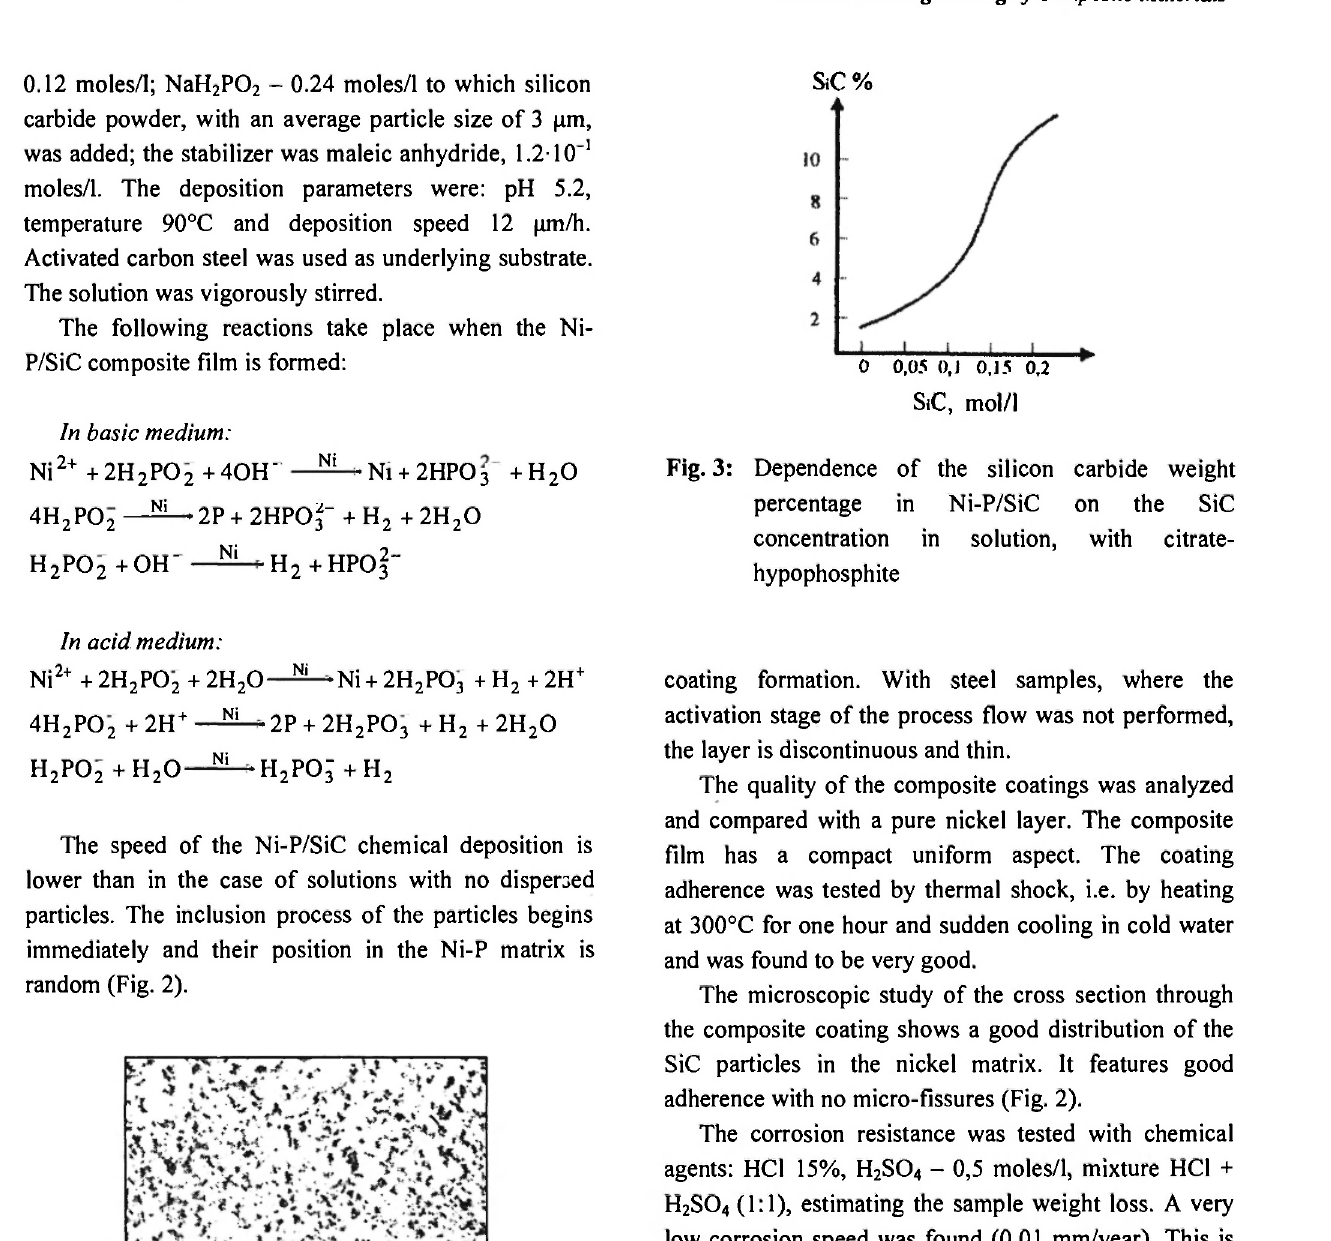
Fig. 2: Microstructure of the composite film Ni- P- SiC coating on steel base Within the concentration interval 0.025-0.2